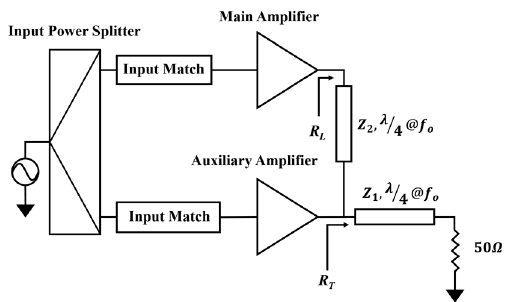
Figure 1. Simplified schematic of the conventional broadband Doherty Power Amplifier.